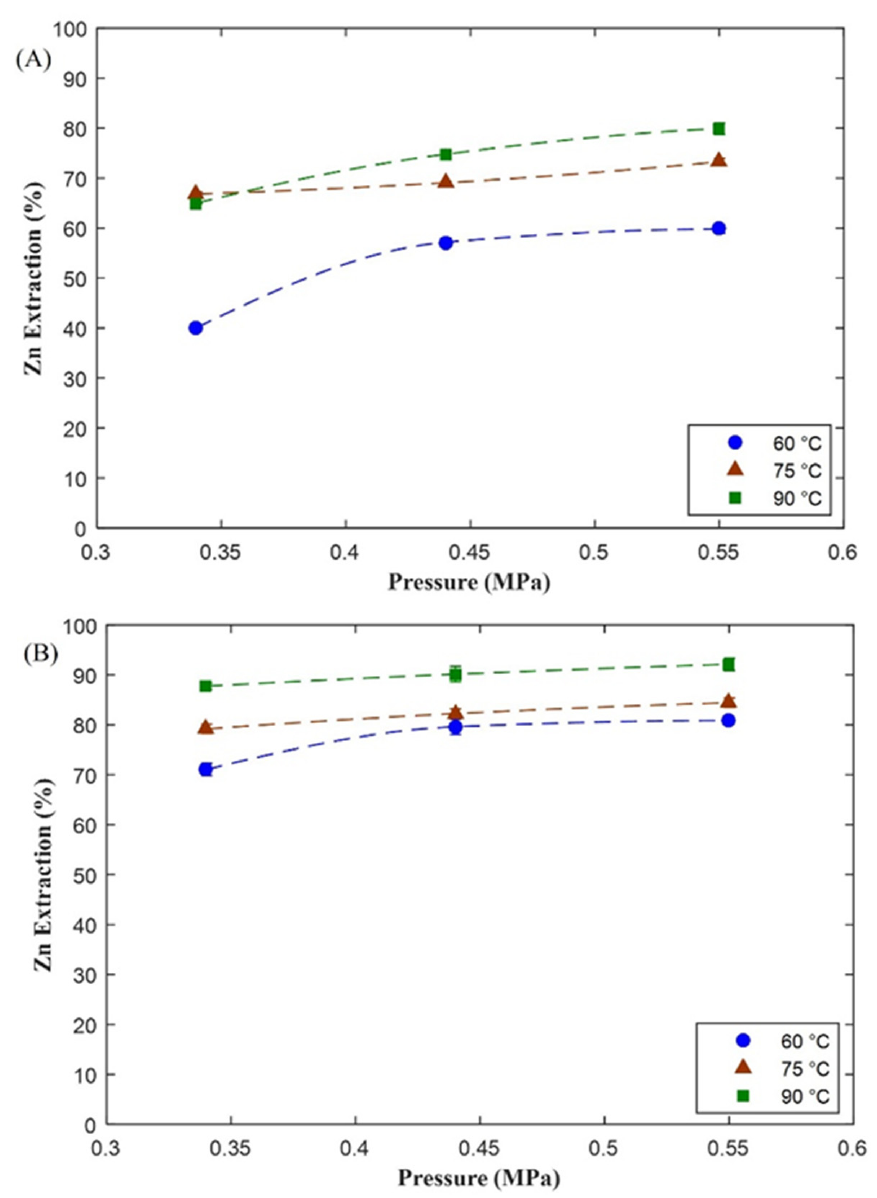
Figure 3. Zn extraction (%) as a function of pressure (MPa) at different temperatures (°C): ( A ) at 1 M H 2 SO 4 ; ( B ) at 2 M H 2 SO 4 (stirring at 600 rpm, for 4 h, 20% solids and a particle size of − 177 μ m).